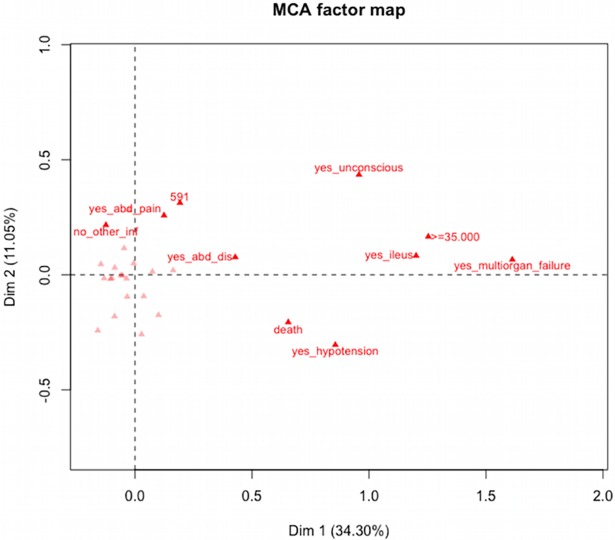
Multiple correspondence analyses.Variable categories contributing to dimension 1 (x-axis) and dimension 2 (y axis); variables with major contribution are close to the cero line in the chart. Ten variables contributing to both dimensions are shown.